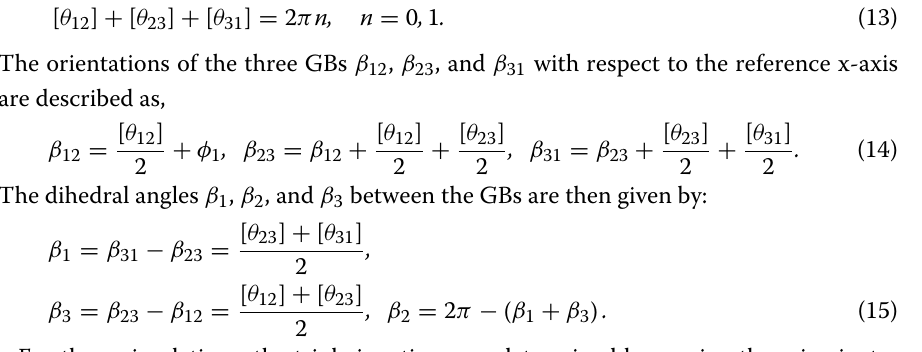
each constructed using the same Franks vector, dipole arm, and period, but each with